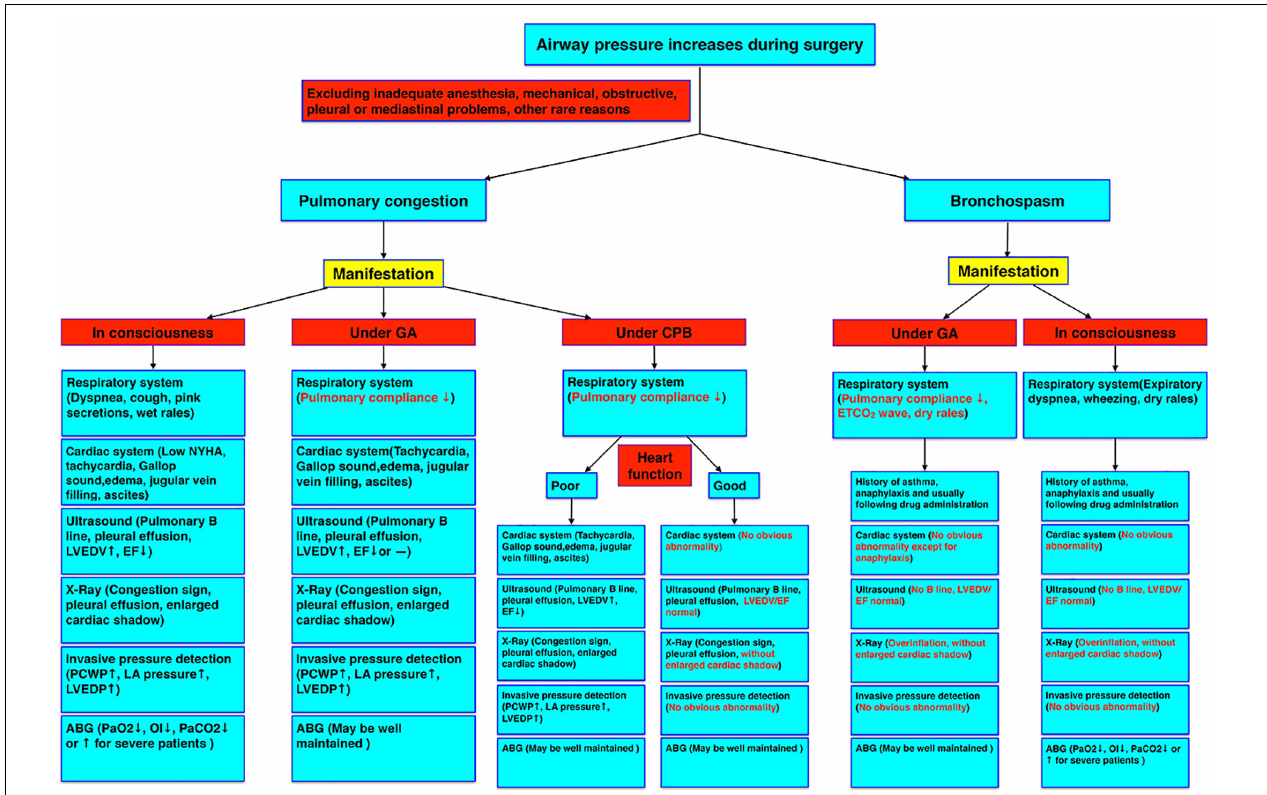
FIGURE 2 | Pulmonary congestion diagnostic criteria under different circumstances. The manifestations of pulmonary congestion under consciousness, general anesthesia, and CPB, and bronchospasm under general anesthesia and consciousness were compared by symptoms and examinations. ABG, arterial blood gas; CPB, cardiopulmonary bypass; EF, ejection fraction; GA, general anesthesia; LA, left atrium; LVEDP, left ventricular end-diastolic pressure; LVEDV, left ventricular end-diastolic volume; NYHA, New York heart association; OI, oxygenation index; PCWP, pulmonary capillary wedge